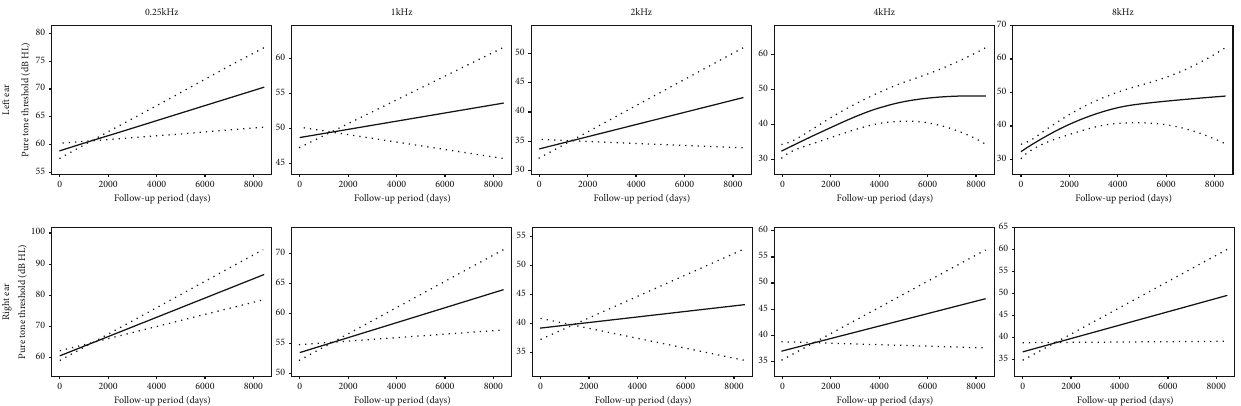
Figure 6: The change of pure tone threshold of 0.25, 1, 2, 4, and 8 kHz over time in both ears of AIFM1 -positive AN patients. Spline smoothing was performed using GAMM (generalized additive mixed model) to explore the change of pure tone threshold with the length of follow-up time. The solid lines represent the fi tting spline. The dashed lines represent the 95% con fi dence